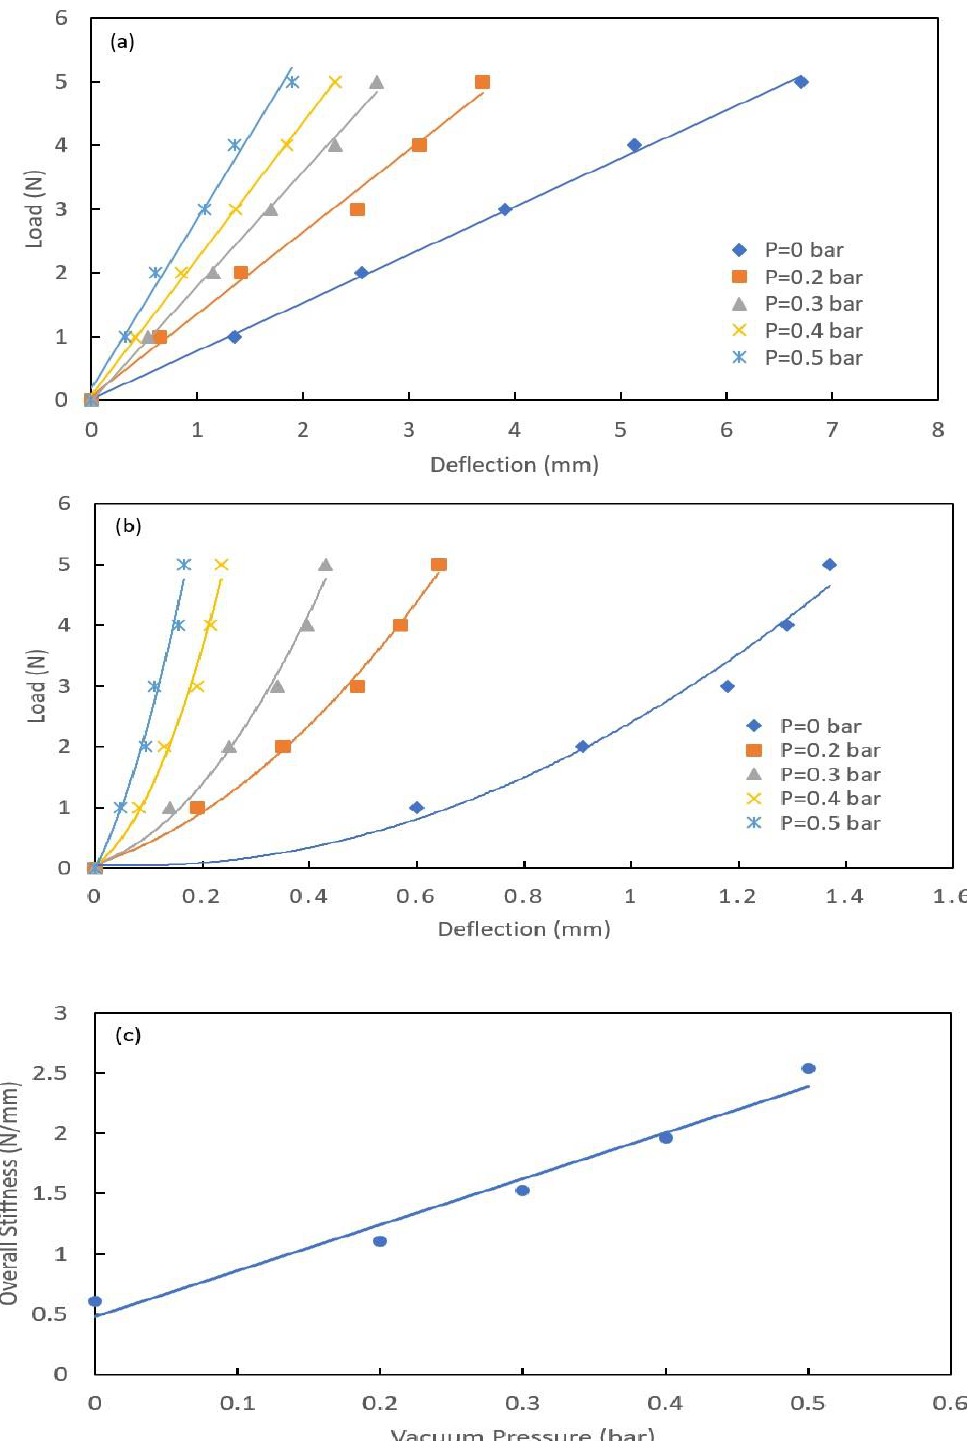
Figure 4. ( a ) Structural load–deflection characteristics of the elastic finger. ( b ) Surface contact load–deflection characteristics of the elastic finger. ( c ) The overall stiffness variation with vacuum pres- sure.